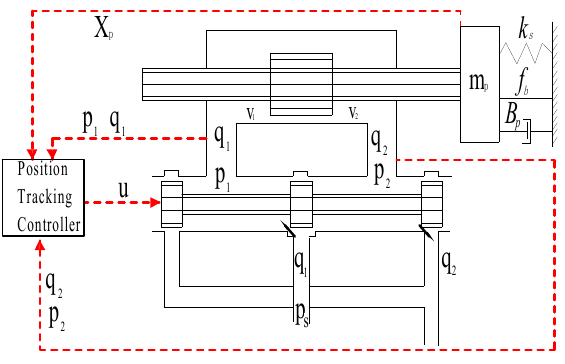
Figure 3. Schematic diagram of wave energy power experimental platform. ( a ) The float motion simulate system, ( b ) hydraulic transmission and electric power processing system.